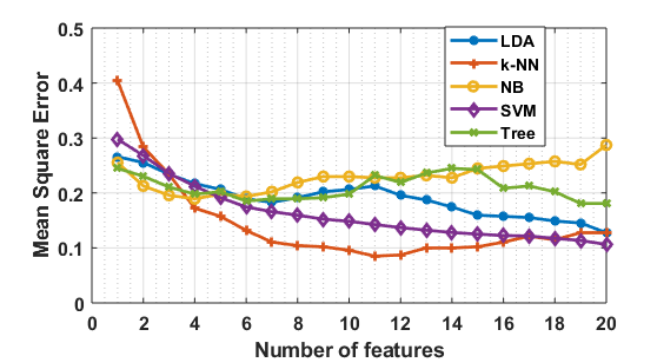
Figure 16. Mean square error with respect to features